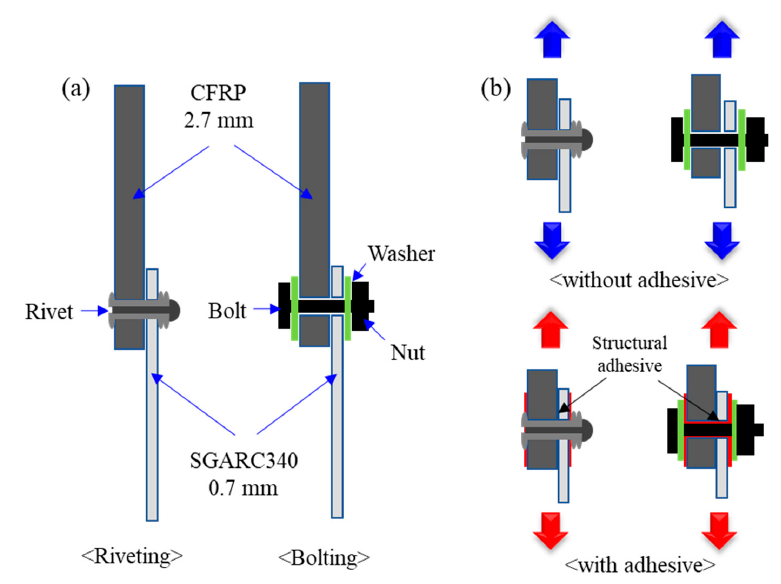
Figure 1. Schematic of the mechanical bonding between CFRP and steel plates: ( a ) riveting/bolting and ( b ) hybrid mechanical bonding with adhesive.